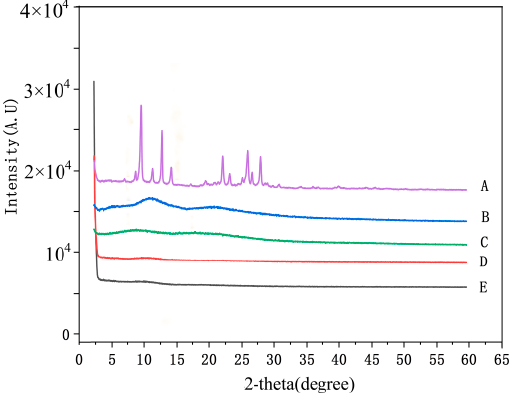
Figure 4. XRD patterns of nanofibers and raw materials. A: emodin; B: PVP; C: CA; D: nanofibers without emodin; E: nanofibers with emodin.